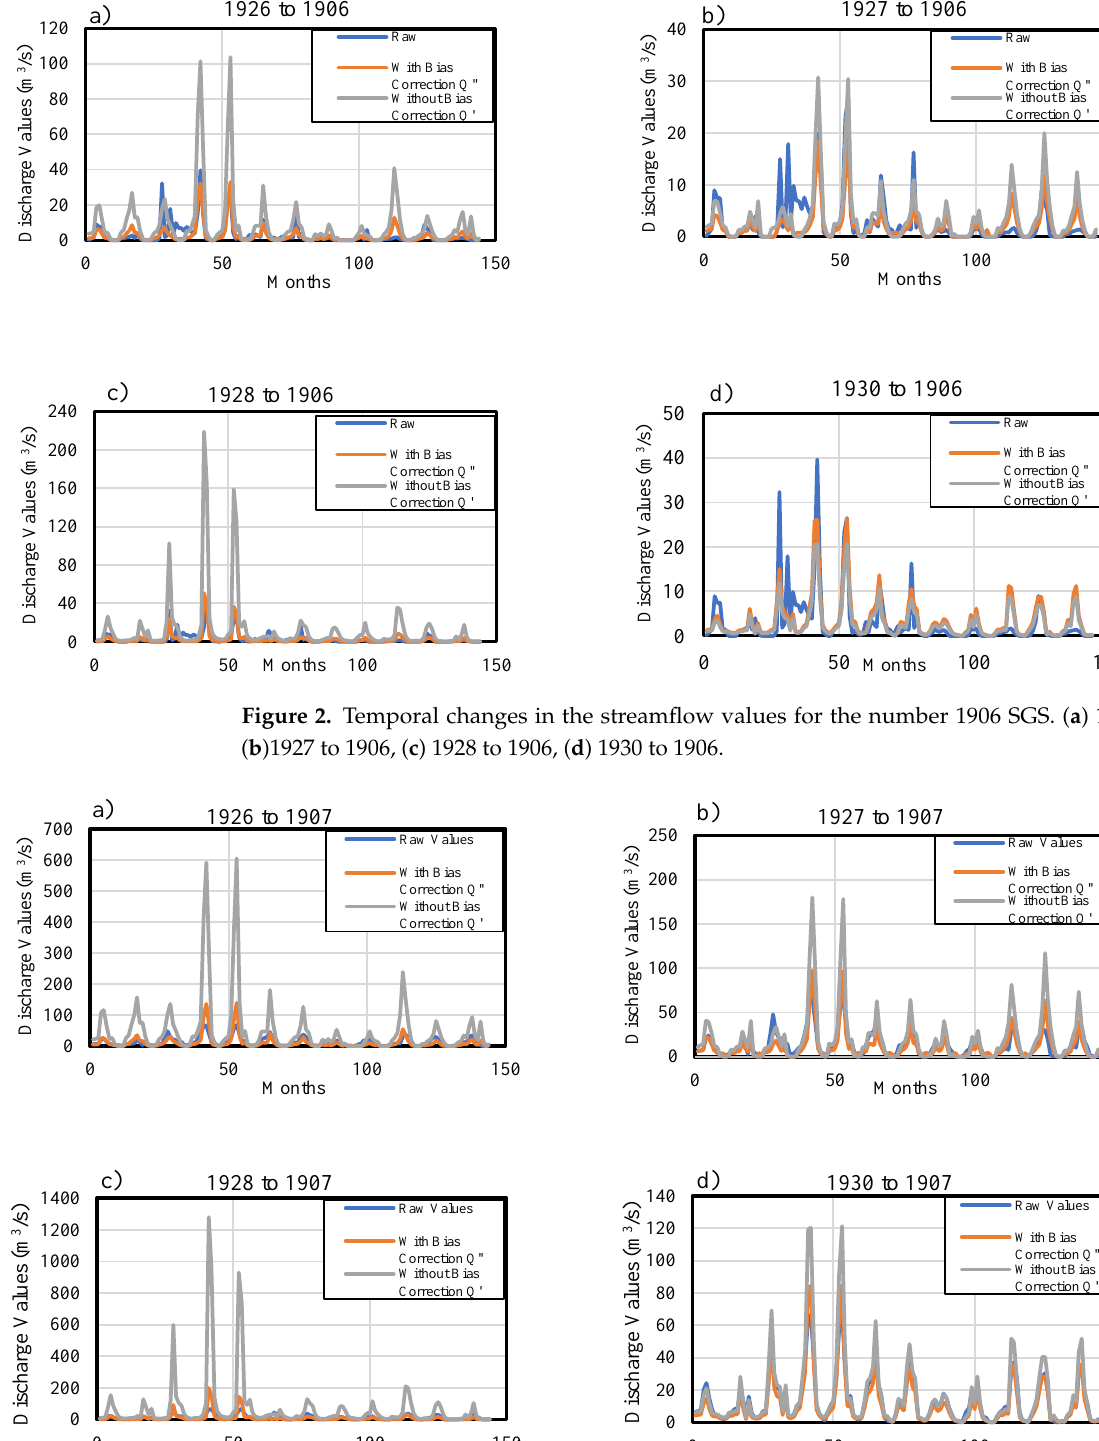
Figure 3. Temporal changes in the streamflow values for the number 1907 SGS. ( a ) 1926 to 1907, ( b )1927 to 1907, ( c ) 1928 to 1907, ( d ) 1930 to 1907